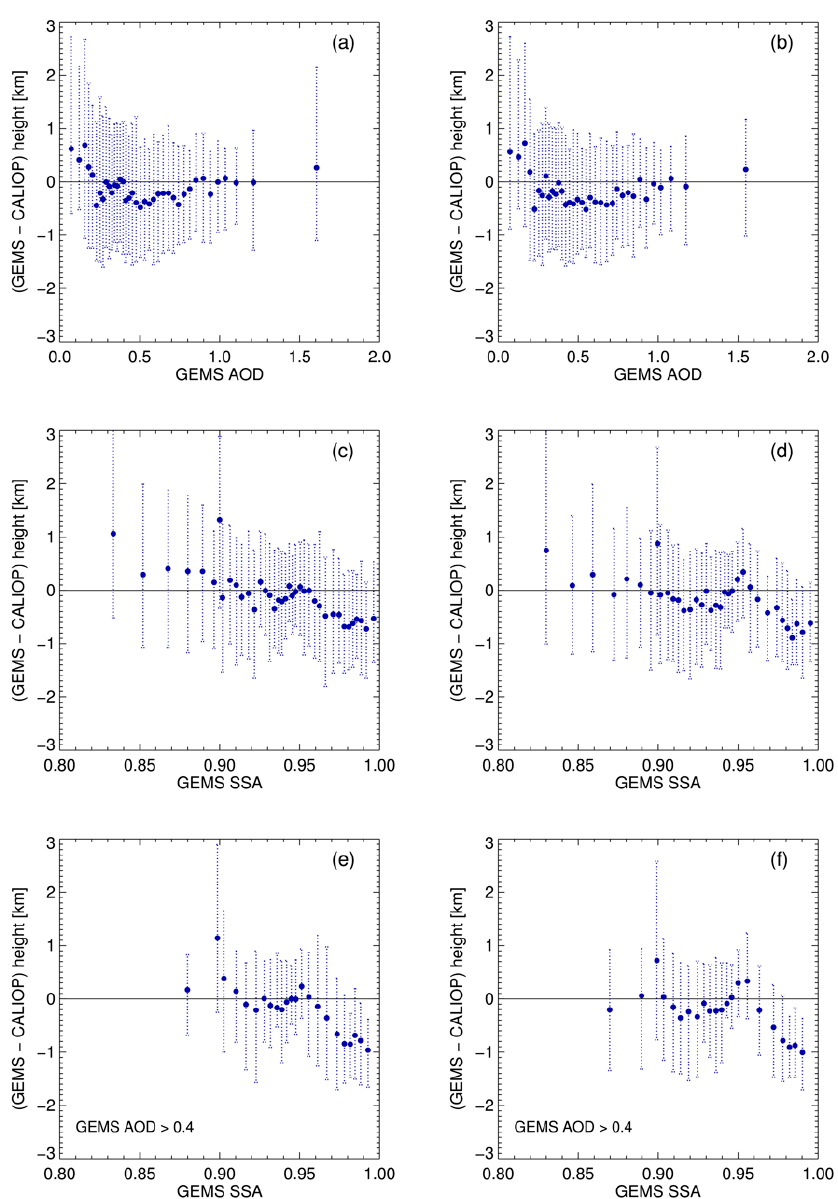
Figure 8. Aerosol layer height (ALH) bias before ( a , c , e ) and after ( b , d , f ) applying the TDCI value. ( a , b ) ALH bias with respect to retrieved AOD; ( c , d ) ALH bias with respect to retrieved SSA for all AOD; and ( e , f ) ALH bias with respect to retrieved SSA for AOD > 0.4. Circles and error bars represent mean and standard deviation (SD) for each bin of 80 collocated data points for GEMS aerosol and CALIOP